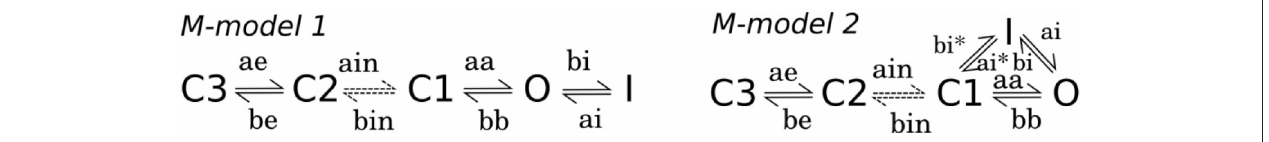
FIGURE 2 | Proposed kinetic mechanisms using Markov models (M-models) for WT hERG (Perissinotti et al., 2015; Romero et al., 2015) showing the transition rates with the corresponding